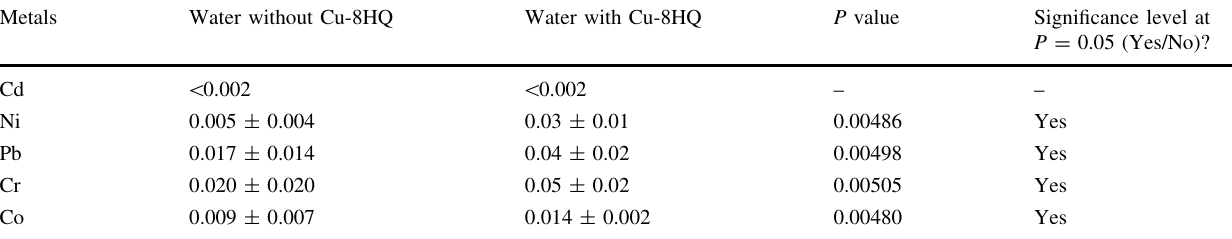
Table 3 Metal ion concentrations ( l g/mL) in water sample before and after co-precipitation procedure application